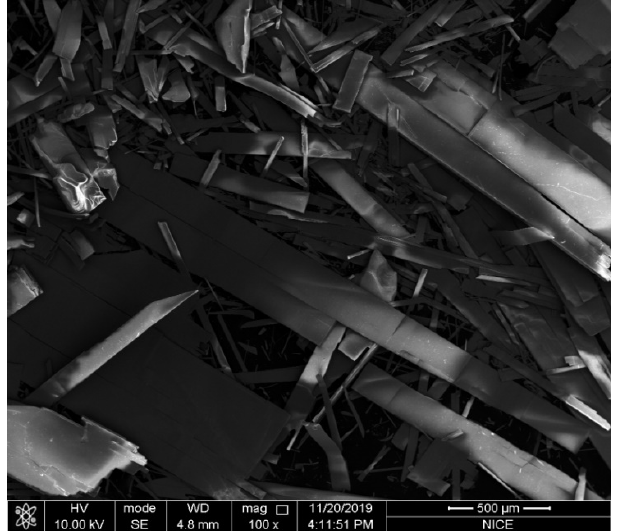
Figure 1. TG/DSC curve of molybdenum trioxide pyrolysis.